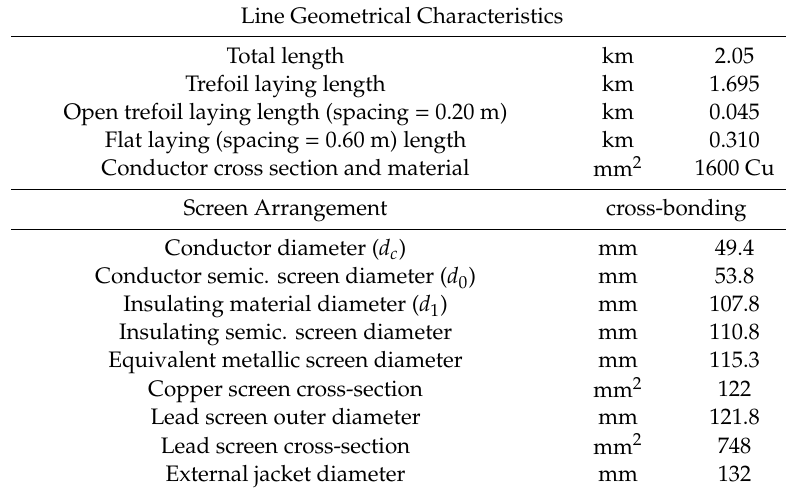
Table 4. Three single-core insulated cables of 380 kV in SE Ferrara Nord-C.le SEF.